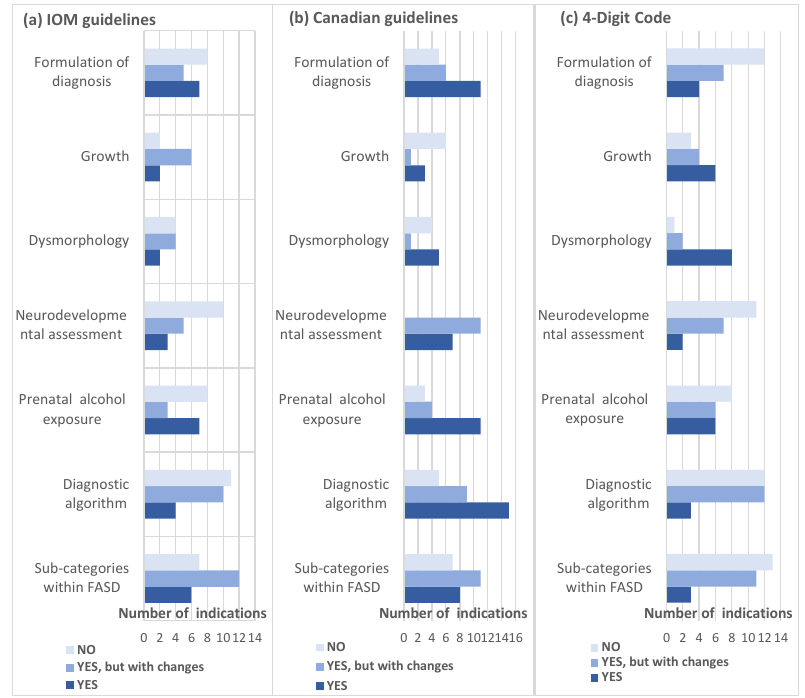
Figure 3. Professionals’ answers to the question of whether each of the recommendations should be implemented in Poland (“no”, “yes, but with some changes”, “yes”). ( a ) IOM guidelines [6]; ( b ) Canadian guidelines [7]; ( c ) 4-Digit Code